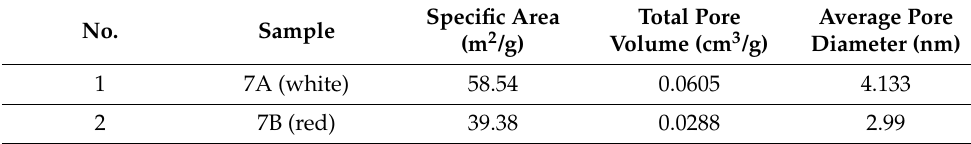
Table 3. The porosity parameters for the investigated samples.